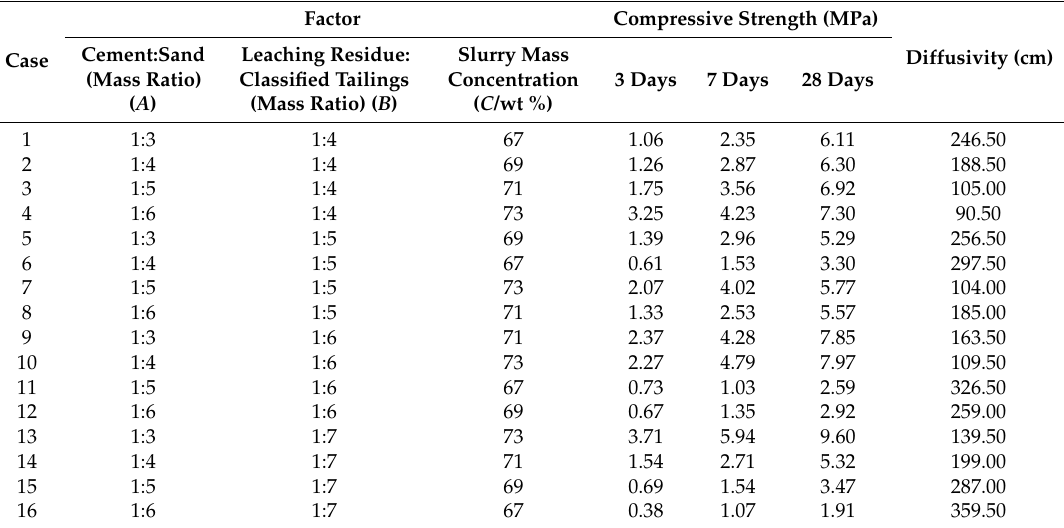
Table 4. The results of the compressive strength test and diffusivity test.